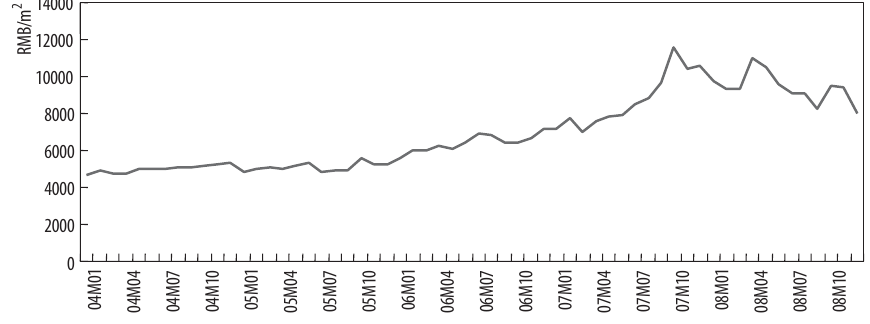
Figure 1. Time series plots of housing